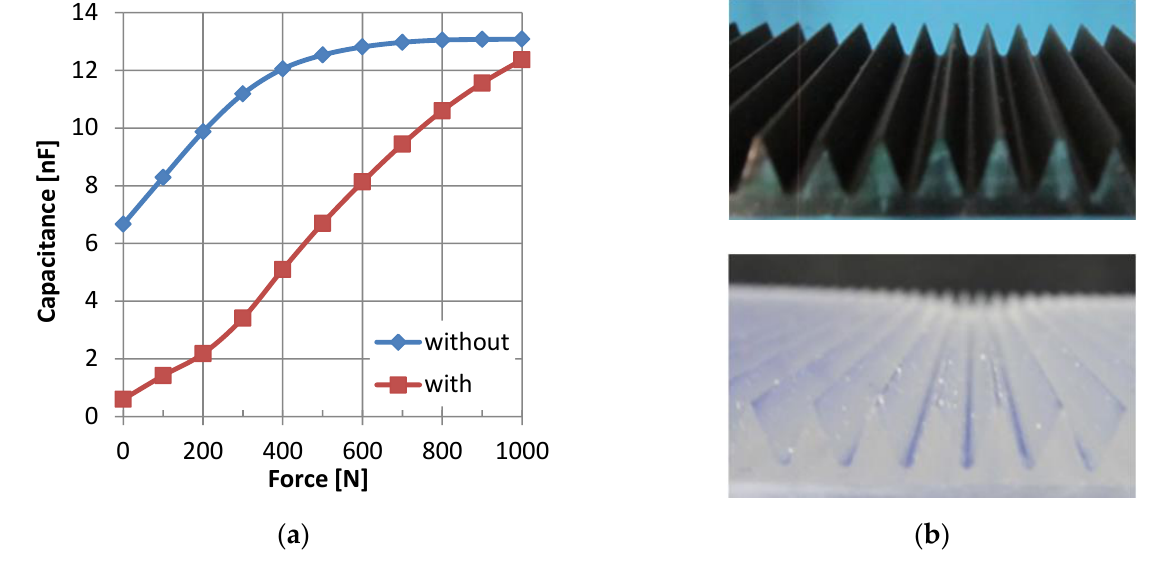
Figure 8. Dependence of the measured capacitance of a sensor with wave profiles covered by electrode layers (with in legend) on the applied compression force compared with the corresponding curve of a sensor without electrode layers on the wave profiles (without in legend) (the sensor area is 100 mm × 100 mm) ( a ) and photographs of a wave profile with electrode layer ( top ) and a wave profile without electrode layer ( bottom ) ( b ) [98].